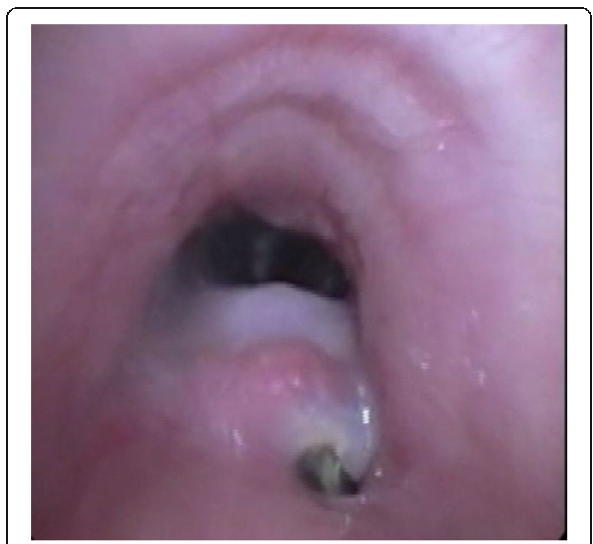
Fig. 2 Supplemental Digital Content 2. Proximal partly obstructing granulation tissue, mucosal ridge, and new tracheoesophageal defect all due to adjacent esophageal